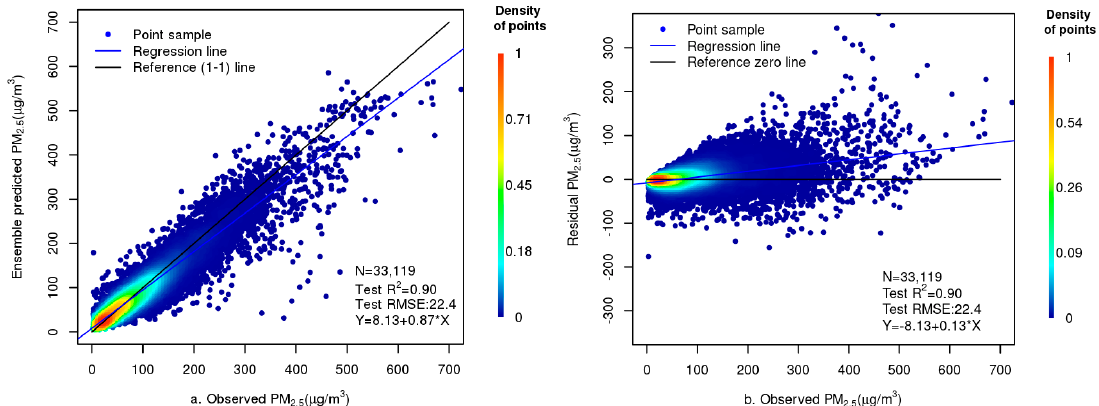
Figure 8. Scatter plots of observed ( a ) and residuals ( b ) vs. observed PM 2.5 ( μ g/m 3 ) in the test data of 2015.